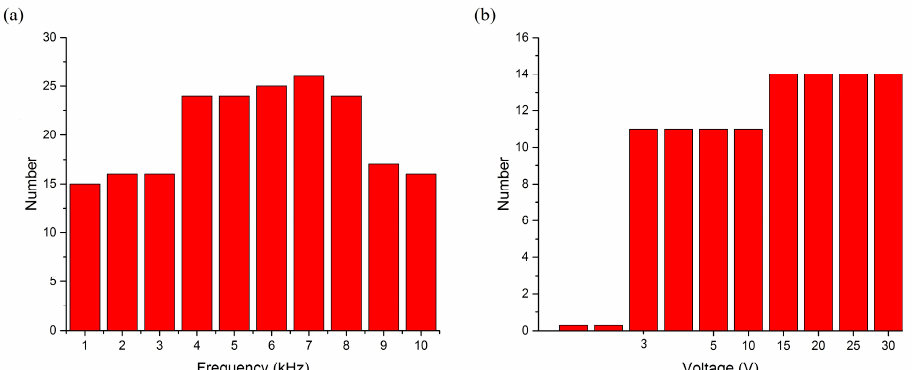
Figure 7. ( a ) Number of micro-objects collected by the bubble at different actuating frequencies; ( b ) number of the microballs collected by the bubble at different actuating voltages.